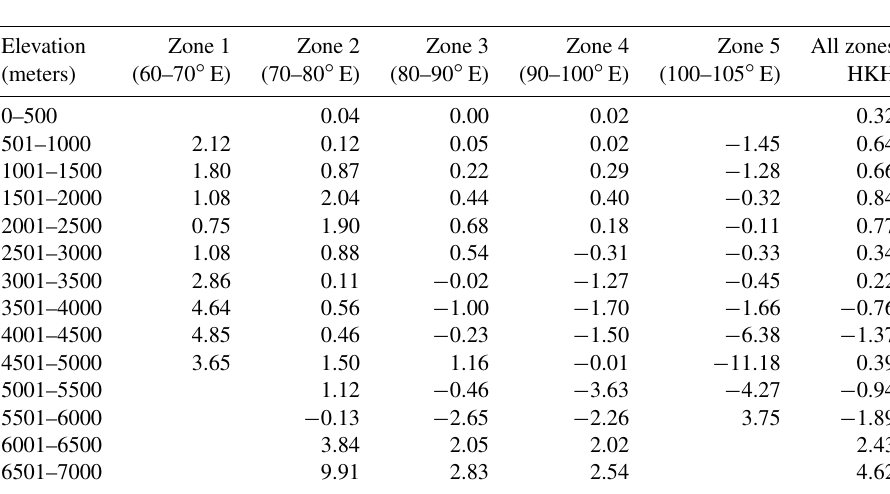
Table 5. The zonal changes in snow cover (in percent) at 500m elevation intervals derived from the linear fit